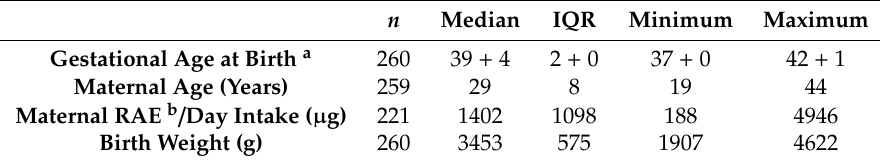
Table 1. Continuous responses of maternal and infant demographic and birth characteristics.